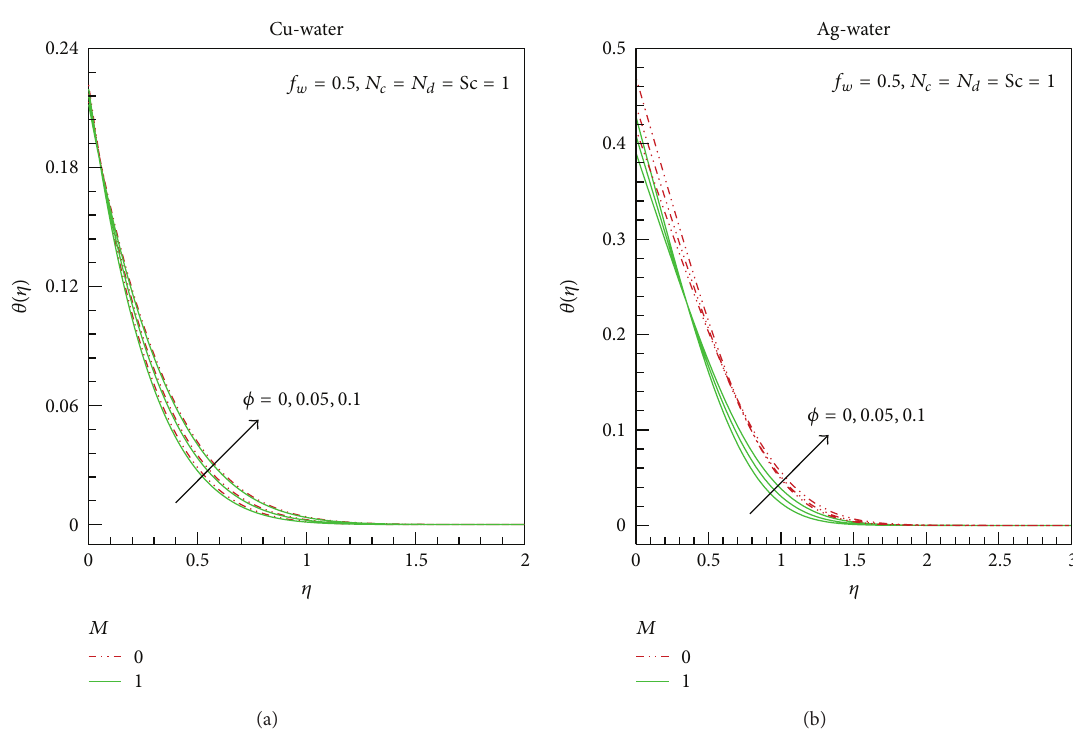
Figure 3: Effects of 𝑓 𝑤 and 𝜙 on dimensionless velocity.